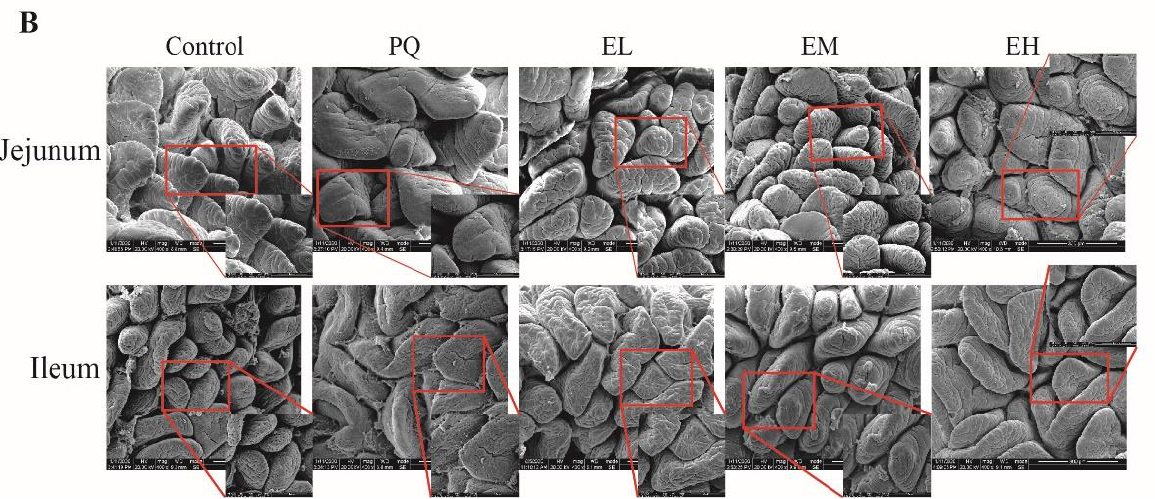
Figure 3. Intestinal mucosal morphology of piglets. ( A ) The histological representative images and histogram of morphological parameters of jejunal and ileal mucosa (magnification 200×). ( B ) Scanning electron microscopy analysis of jejunal and ileal mucosa (magnification 400×, 1000×). PQ = 4 mg/kg paraquet; EL = 0.005% ellagic acid + 4 mg/kg paraquet; EM = 0.01% ellagic acid + 4 mg/kg paraquet; EH = 0.02% ellagic acid + 4 mg/kg paraquet. n = 8. Data are shown as mean ± SEM. * means the difference was significant when compared to the control group. ns